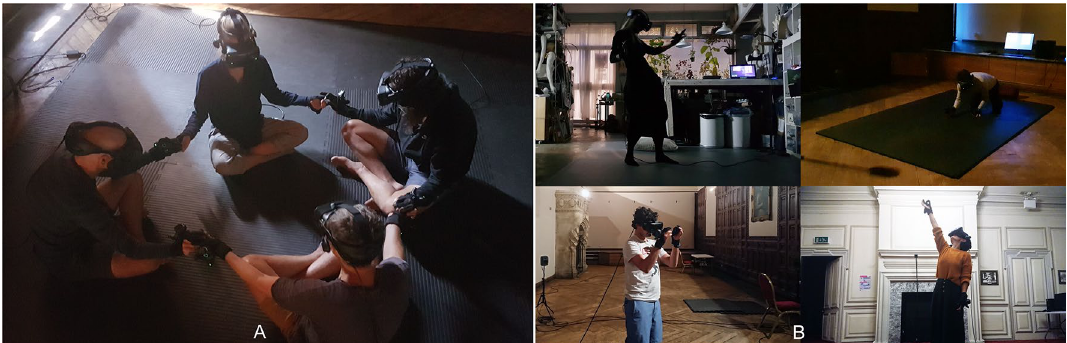
Figure 2. ( A ) the co-located version of Isness (Isness-C), an intersubjective multi-person group VR experience which Glowacki et al. showed produces MEQ30 scores comparable to moderate to high doses of YDs; ( B ) the distributed version of Isness (Isness-D), with four participants simultaneously joining a session from different Isness-D nodes distributed across the